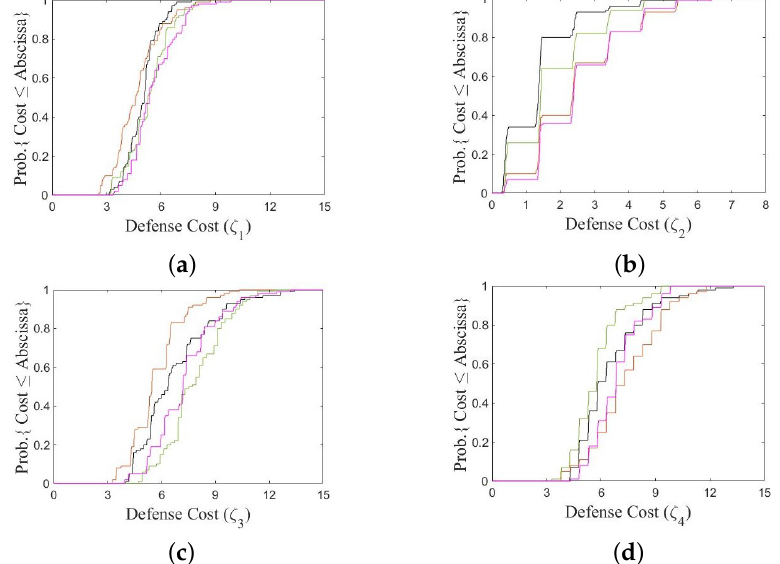
Figure 5. CDF of defense cost function against pincer formation, ( a ) ζ 1 ; ( b ) ζ 2 ; ( c ) ζ 3 ; ( d ) ζ 4 , with four PSO runs.